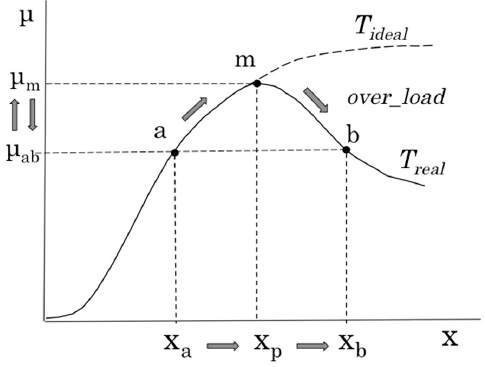
Figure 2. Throughput characteristics of the server system.